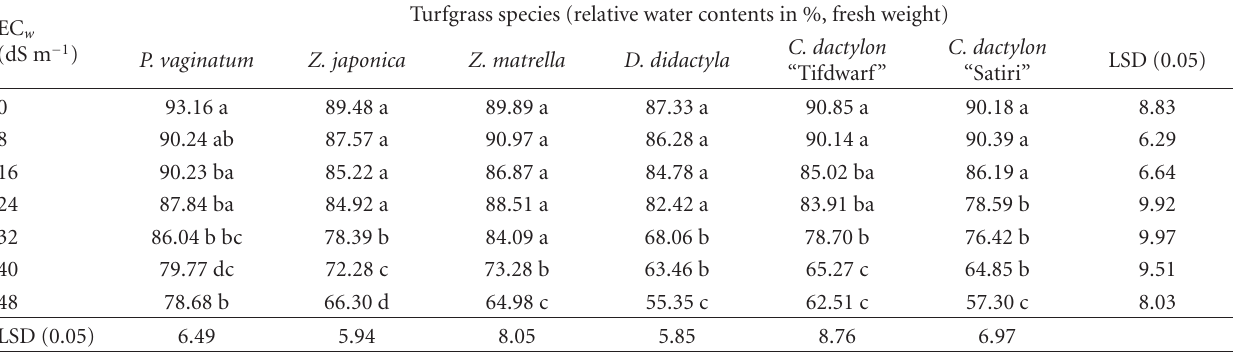
Table 5: E ff ect of salinity on leaf relative water content of six turfgrass species.